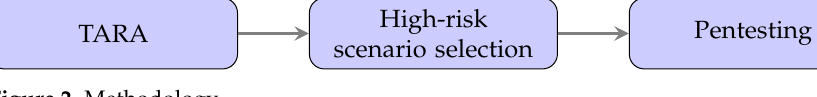
Figure 2. Methodology.